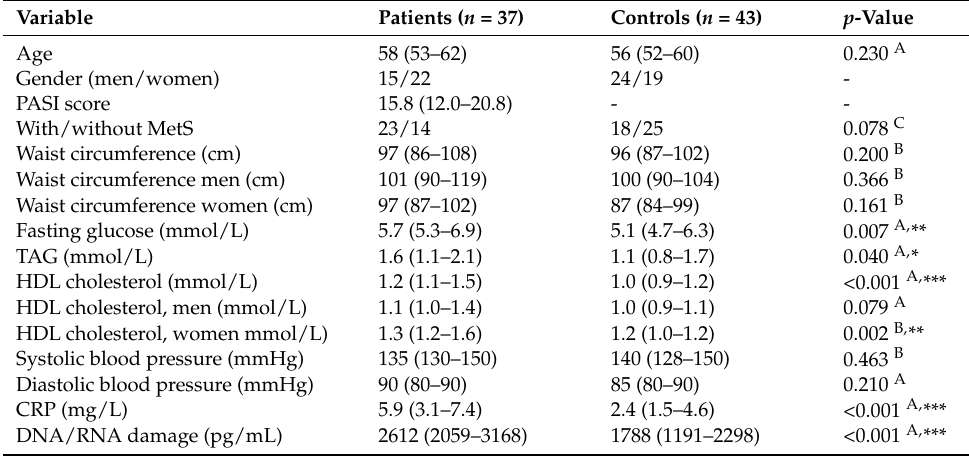
The basic characteristics of the subjects in the experimental (patients) and control group, the PASI score (Psoriasis Area Severity Index score), the diagnostic criteria of the MetS (metabolic syndrome), the level of CRP (C-reactive protein), and the level of DNA/RNA damage.